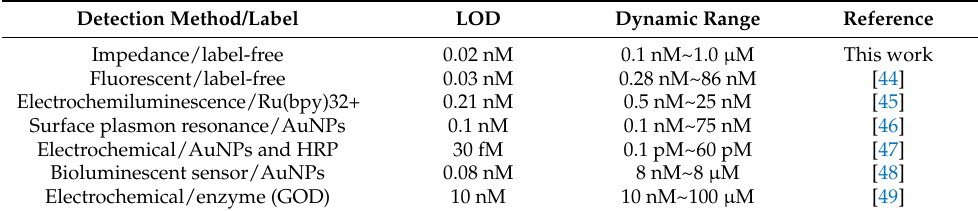
Figure 5. ( A ) Impedance spectra corresponding to various concentration of target protein: (a) 0 M, (b) 0.1 nM, (c) 1 nM, (d) 10 nM, (e) 100 nM and (f) 1.0 μ M of thrombin. EIS experiments were obtained in EB solution containing 0.1 mM Fe(CN) 63 − /0.1 mM Fe(CN) 64 − (1:1 molar ratio) and 0.1 M KNO 3 . Solid curves represent the fitting results from an equivalent circuit. ( B ) Linear calibration curve for ∆ R ct vs. log (C thrombin /nM), where C thrombin represents thrombin concentration. The inset of ( B ) is plots of ∆ R ct against thrombin concentration. Errors bars are obtained based on three independent measurements. Table 1. Limit of detection (LOD) and range of various thrombin biosensors.